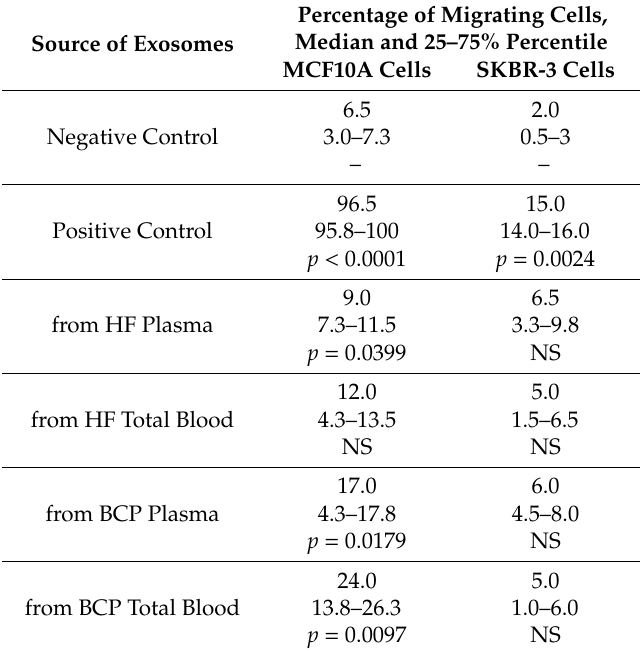
Table 4. The Proportion of Motile Cells in Response to Exosome